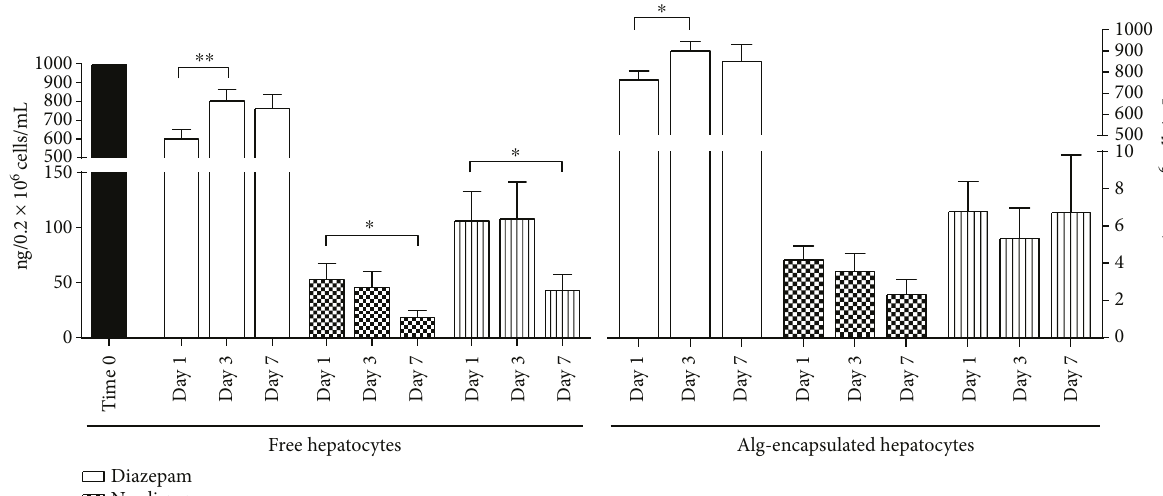
Figure 5: Diazepam metabolism in free and alginate-microencapsulated hepatocytes. Diazepam (white bars) was added at days 1, 3, and 7 on free and alginate-encapsulated hepatocytes, and supernatant was retrieved after 6 hours of culture. Diazepam and its metabolites nordiazepam and temazepam were measured by LC-MS/MS in 4 independent experiments. ∗ p < 0 05 , ∗∗ p < 0 01 .